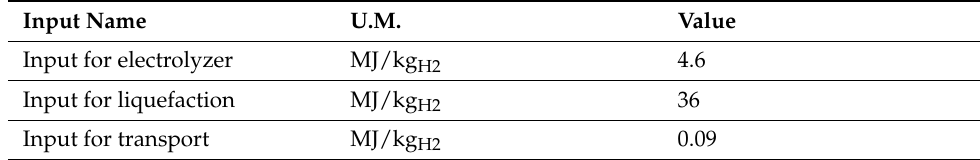
Table A1. Main inputs for LH 2